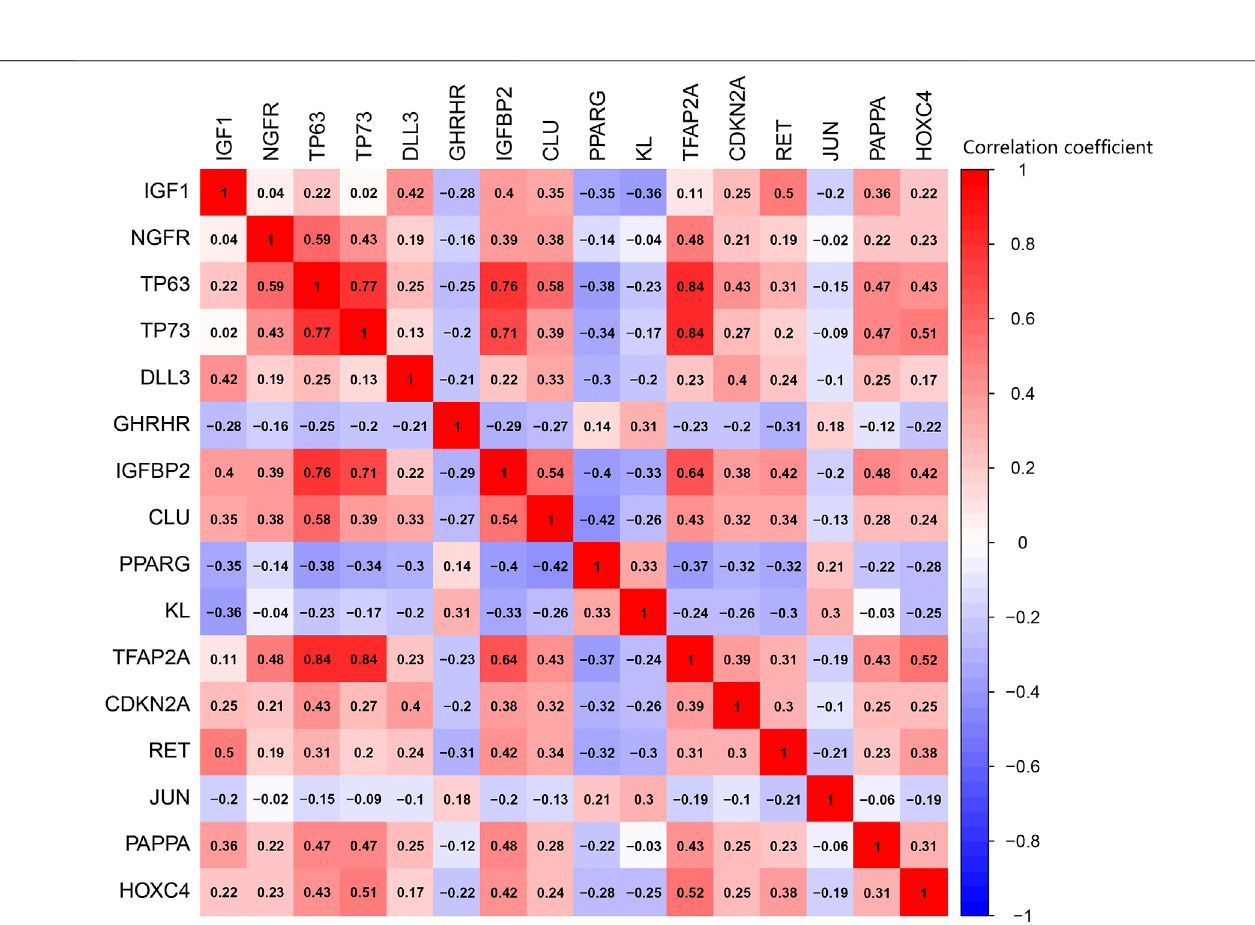
Frontiers in Genetics |